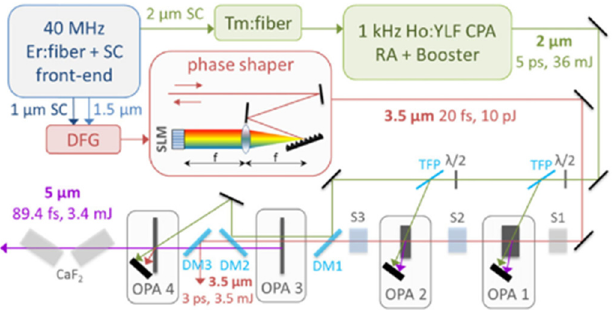
Figure 12. Setup of the 2 μ m pumped MIR OPCPA. Reprinted with permission from [54].